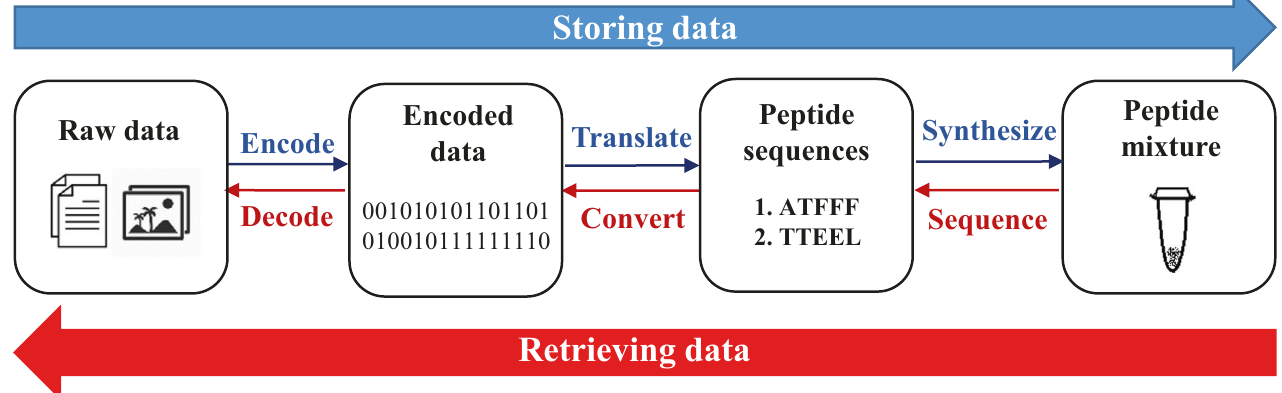
Fig. 1 Overview of the process of storing and retrieving data into and from peptides. The direction in blue represents the data storing process, while the direction in red represents the data retrieving